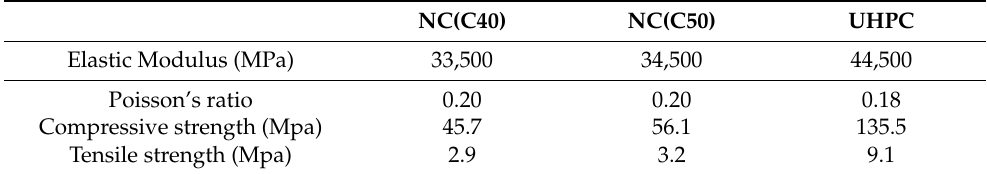
Table 2. Mechanical properties of UHPC and